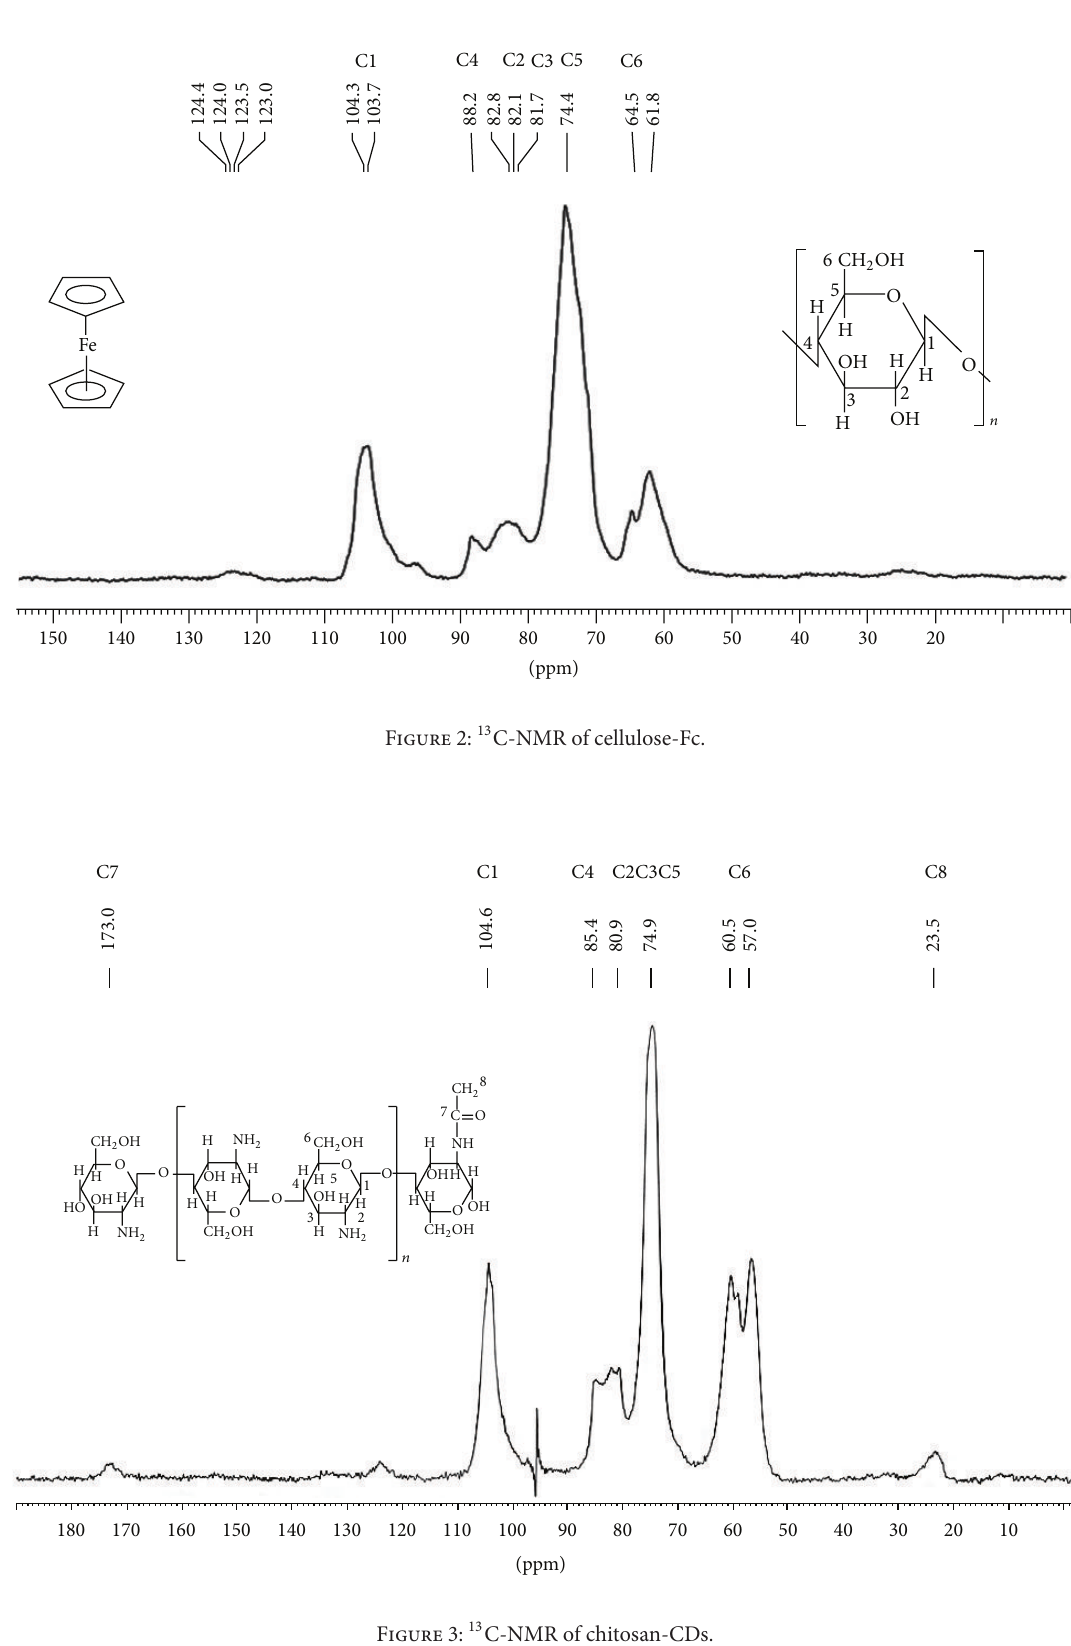
Figure 3: 13 C-NMR of